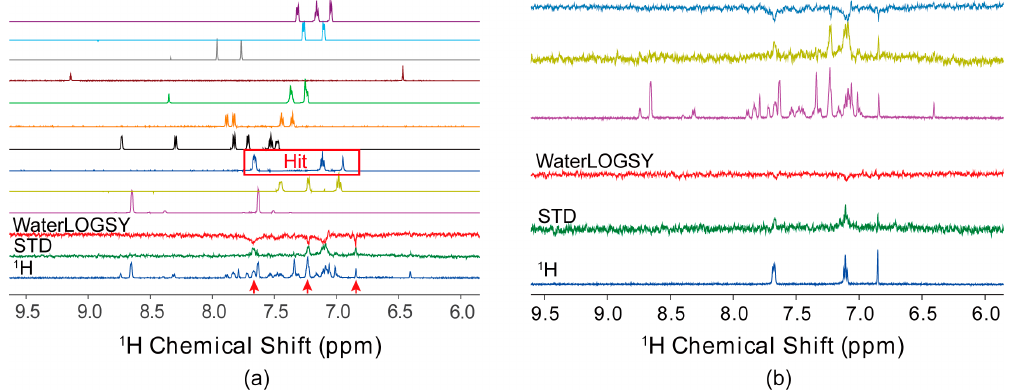
Figure 1. Ligand-observed NMR fragment-based screening. ( a ) The primary screening spectra for a typical cocktail. The top ten are the reference spectra for each component in the cocktail, while the bottom three are the WaterLOGSY, saturation transfer difference (STD), and 1 H spectra for the cocktail as annotated. Red arrows denote signals from the hits. Slight chemical shift displacements may be observed because the reference and screening spectra were acquired in different buffers. ( b ) Secondary screening spectra in singleton for the identified hits. The top three spectra from the primary screening are overlaid with the secondary ones (bottom three) for comparison.